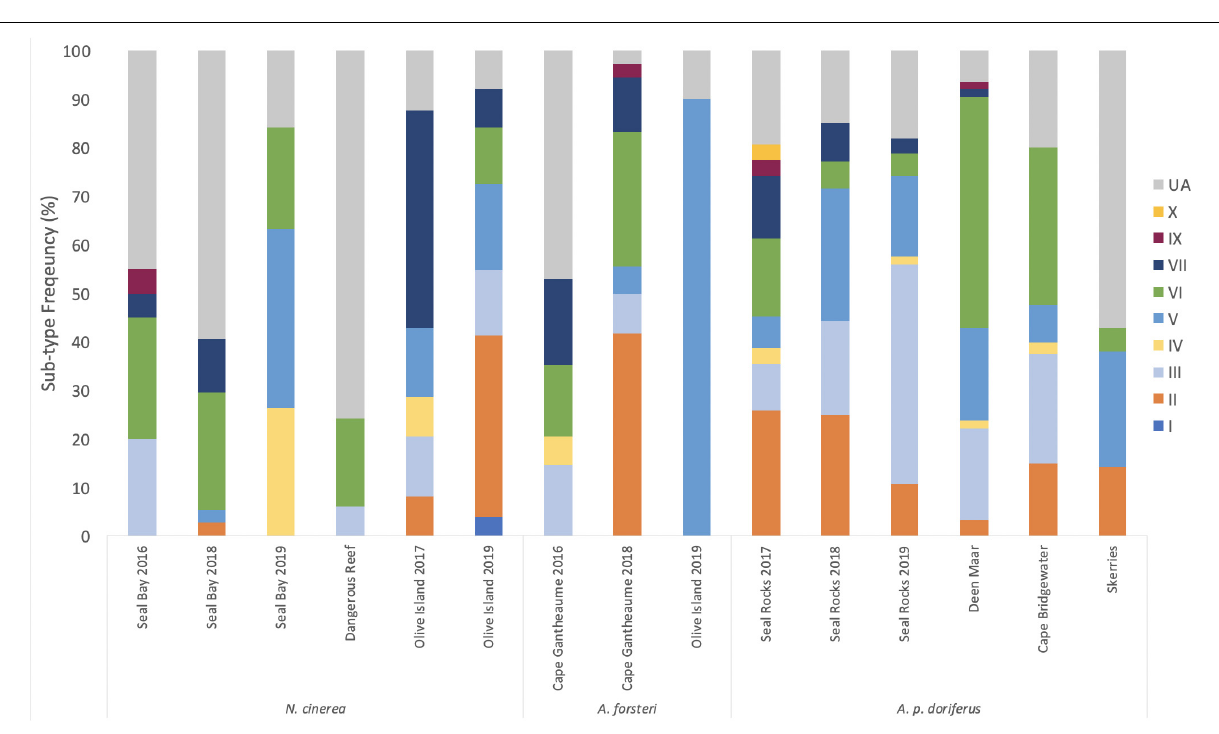
Previous studies have suggested that E. coli is